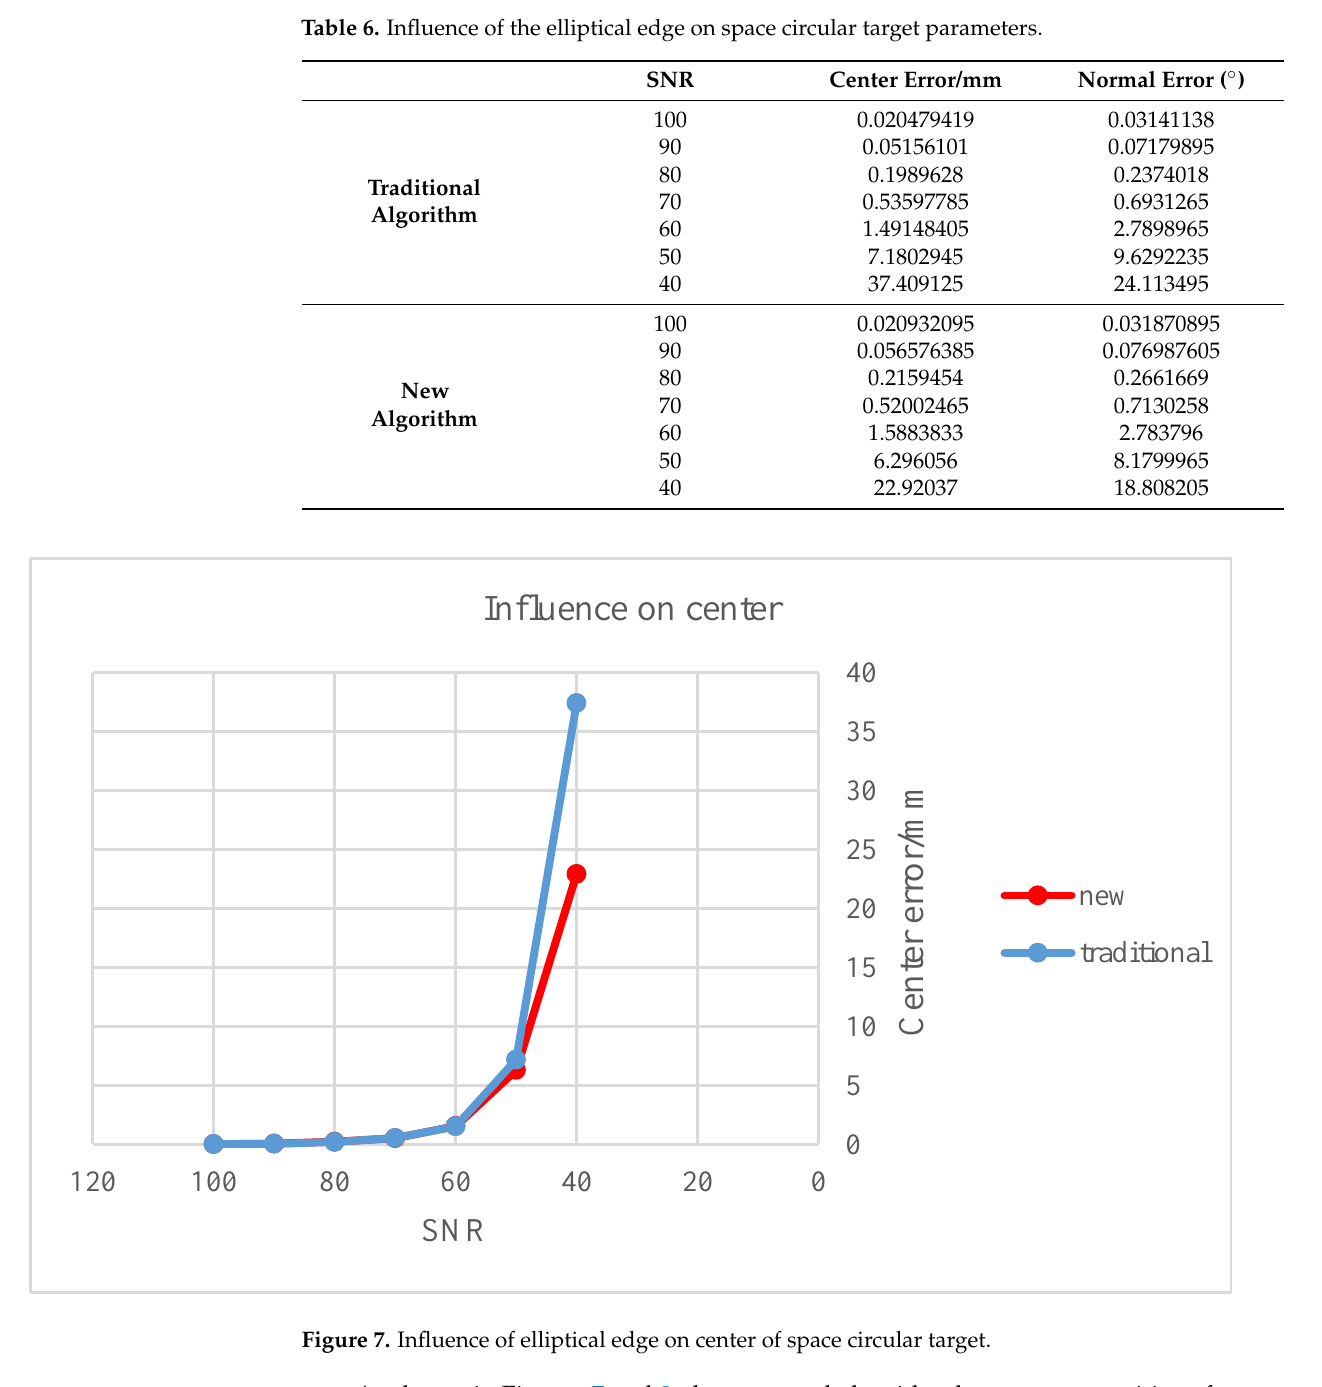
Figure 8. Influence of the elliptical edge on the normal vector of the space circular target. Table 6. Influence of the elliptical edge on space circular target parameters. SNR Center Error/mm